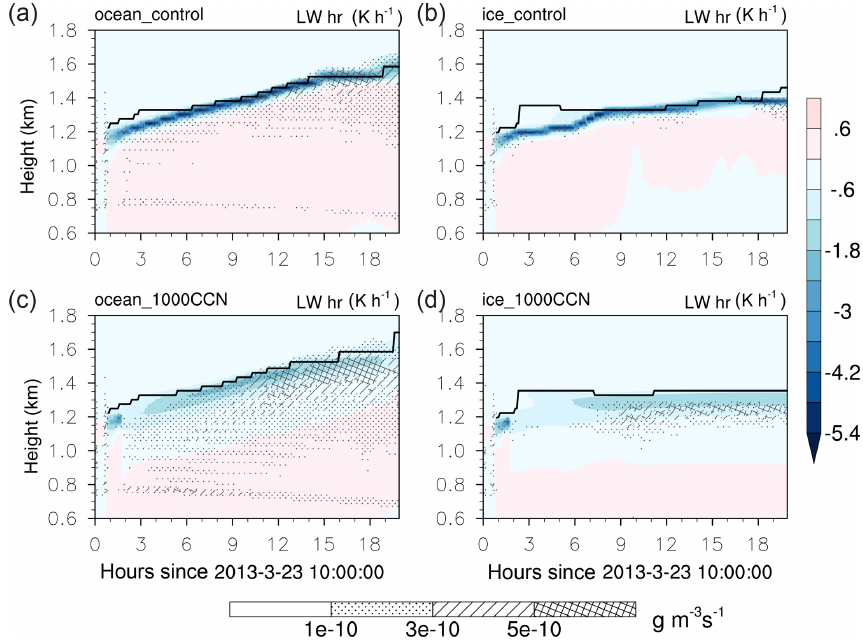
Figure 5. Domain-averaged LW heating rate (color), immersion freezing rate (hatching), and cloud top of the uppermost cloud layer, where 80% of the domain grid points are cloud-covered ( q c > 0 . 01gm − 3 ) and are shown for the (a) ocean_control and (b) ice_control simulations and (c, d) the respective 1000CCN simulations. Only the range where immersion freezing occurs ( T < 258K) is